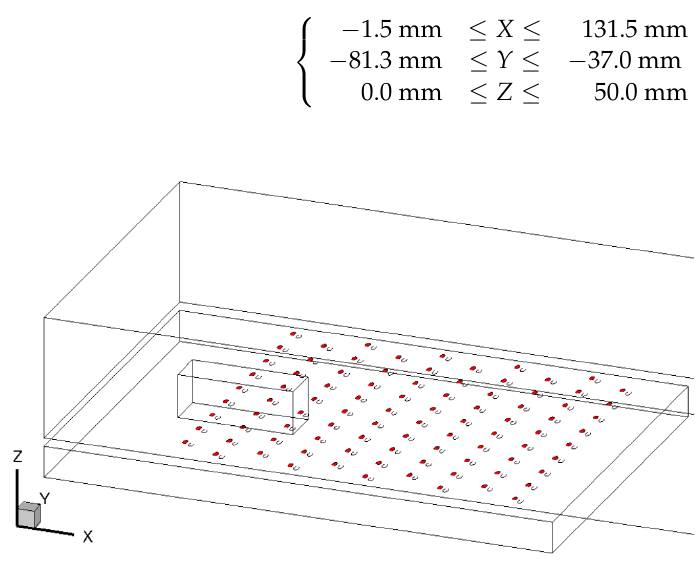
Figure 5. Measurement box of the cold wire